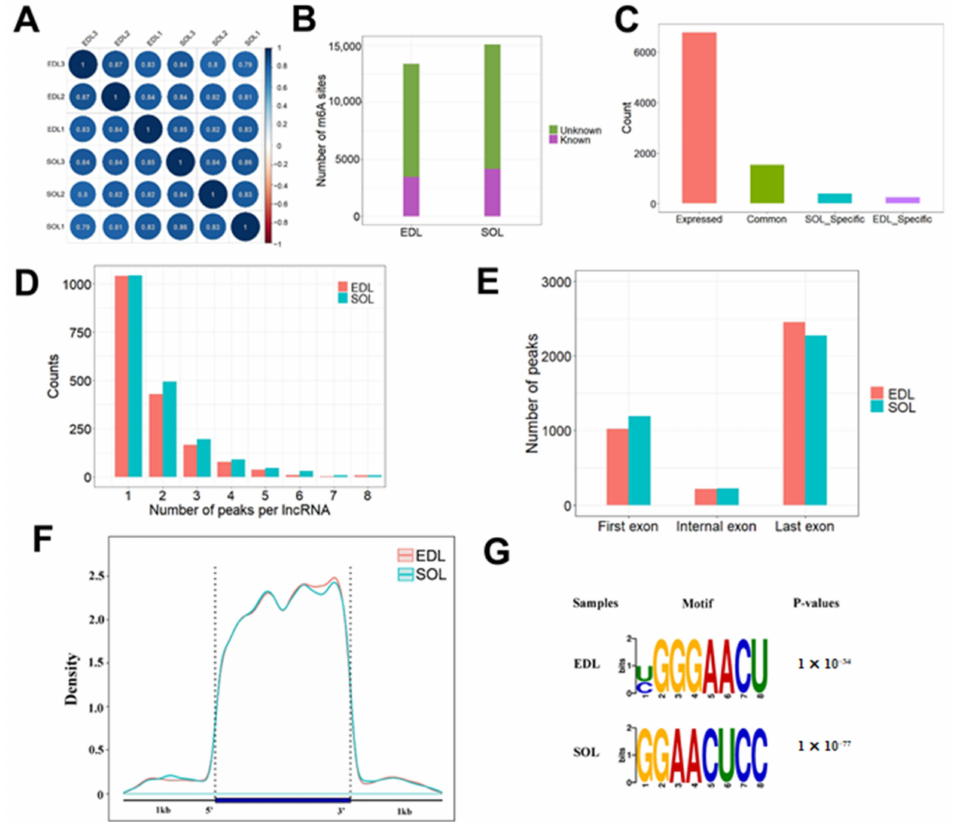
Figure 4. Overall features of lncRNAs m 6 A methylation in oxidative and glycolytic skeletal muscles. ( A ) Pearson correlation analysis of MeRIP-seq data between each pair of samples. The samples were hierarchically clustered. The intensity of the color represented the similarity, and the black outlining was drawn according to the hierarchical cluster. ( B ) The number of m 6 As found in each tissue. Any m 6 A site that did not overlap with any site in RMBase were labelled as ‘unknown’. ( C ) Histogram showing the distribution of lncRNAs with m 6 As. Expressed: expressed lncRNAs; Common: lncRNAs with m 6 As in two tissues; SOL - specific: lncRNAs with m 6 As in SOL only; EDL - specific: lncRNAs with m 6 As in EDL only. ( D ) The distribution of peak number of m 6 A-modified lncRNAs. ( E ) Metagene profile of enrichment of m 6 As in lncRNAs. ( F ) Histogram showing the distribution of m 6 As in the three regions of lncRNAs. ( G ) The enriched consensus motif of m 6 As in